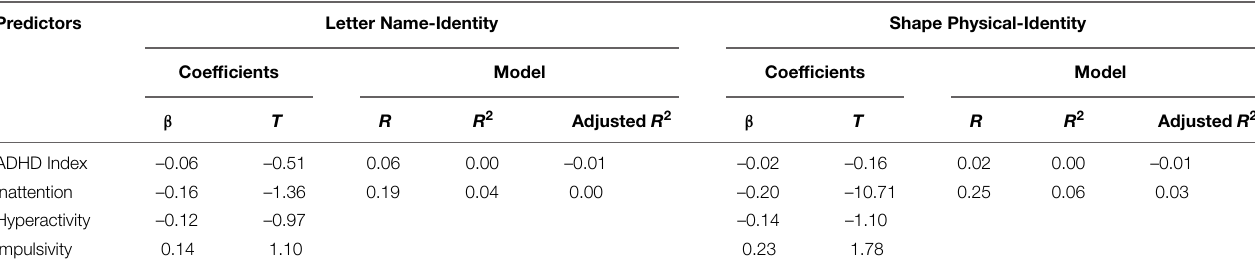
TABLE 2 | The models of regression analyses predicting the size of visual field advantage from scores on the Attention-Deficit/Hyperactivity Disorder (ADHD) index, inattention, hyperactivity, and impulsivity subscales.